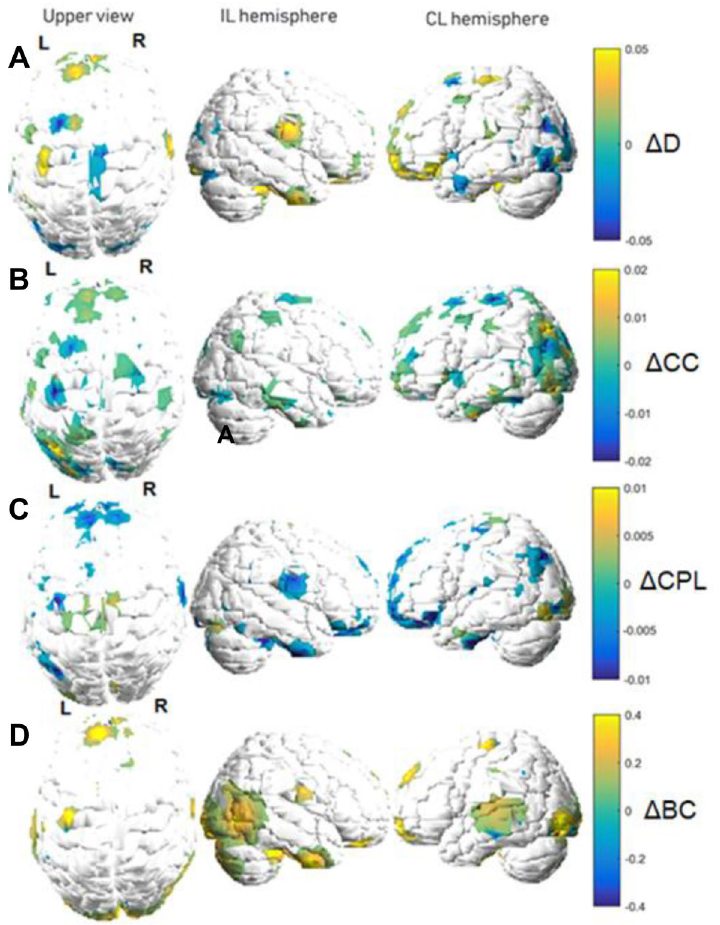
Figure 3. Graph metric changes between functional magnetic resonance imaging acquisitions (control stroke group). Variations are shown in a relative color scale, according to Equation 6. A , degree (D); B , clustering coef fi cient (CC); C , characteristic path length (CPL); D , betweenness centrality (BC). IL: ipsilesional; CL: